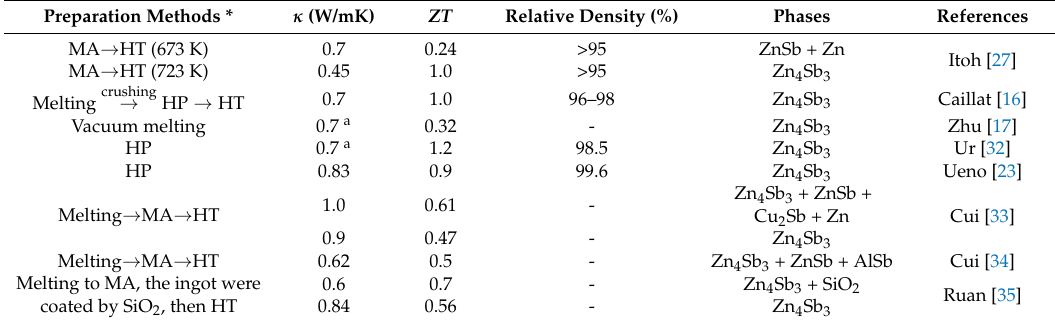
Table 3. Thermoelectric properties at 600 K for Zn 4 Sb 3 bulk specimens prepared by different methods. Preparation Methods